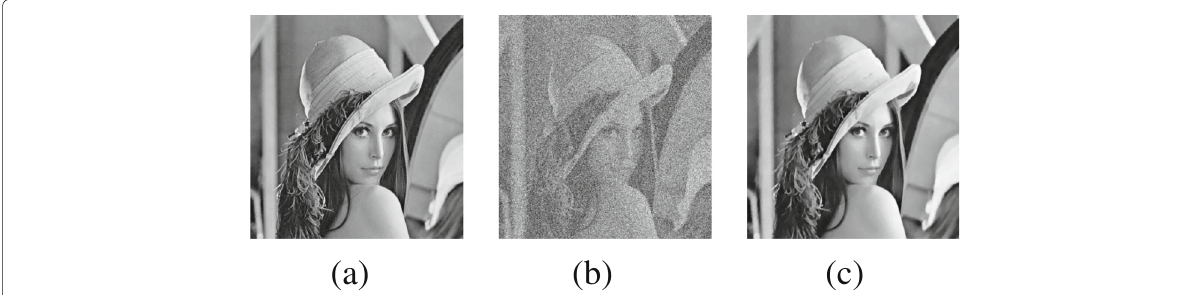
Fig. 15 Denoised result on Lena; a true image; b noisy image with Gaussian noise with σ = 15 ; c processed with method M3